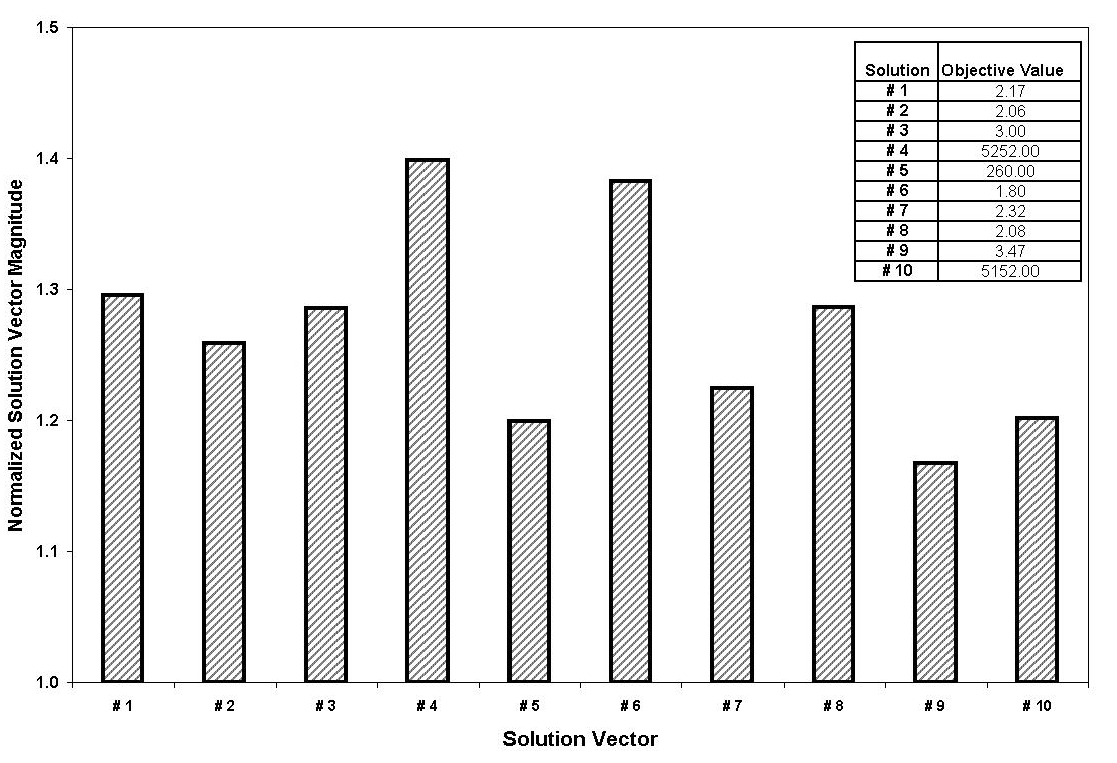
Fig. 7. Magnitude of solution vectors, normalized with respect to that of the baseline, for ten different ES optimization runs are shown here. The corresponding final objective function values are also shown in the table. as possible for maximum isolation. Another objective was to deliberately place the roll mode at or near the front suspension tramp mode. Neither of these two objectives can be pursued if there is no control over the roll mode frequency. Complete decoupling conditions given by Eq. (10), shows that once a decoupled roll mode is obtained, one can always scale the global [ K ] matrix by a constant factor α , to adjust the roll mode frequencywithout disturbing the decoupling. However, scaling may not be possible in many situations as it might force some of the mount stiffness values below the production feasible lower limits. Therefore, Eq. (18) needs to be modified in some